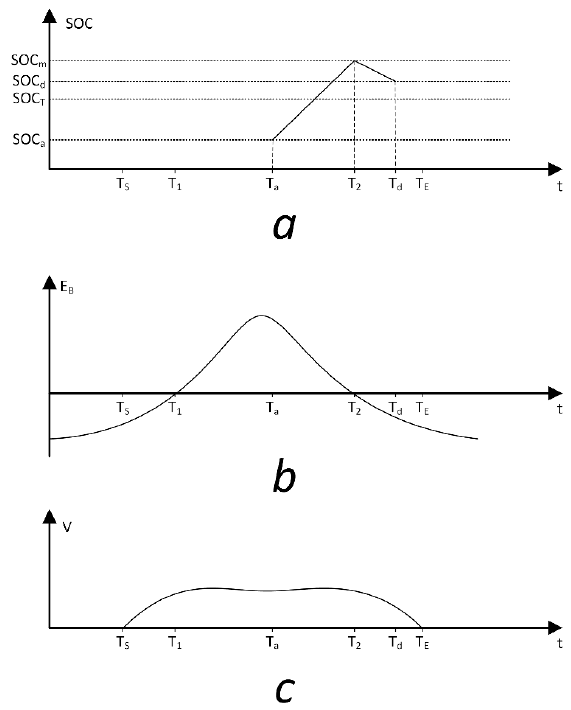
Figure 2. ( a ) State of charge of one EV; ( b ) energy balance of the prosumer; ( c ) EV presence at the parking lot.